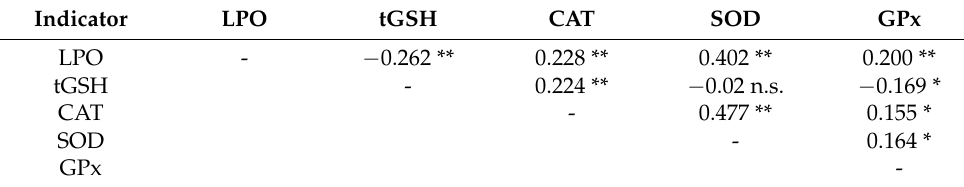
Table 4. Phenotypic correlations (r) between oxidative stress markers.